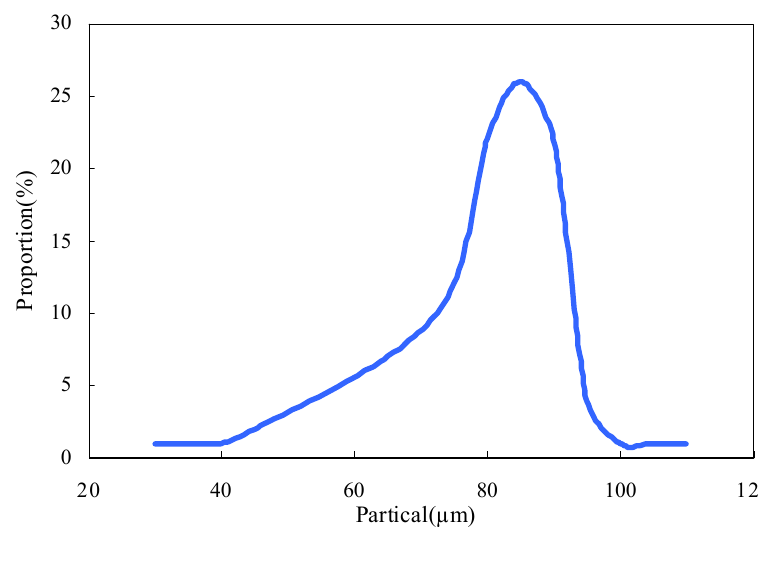
Figure 3. Particle size distribution of